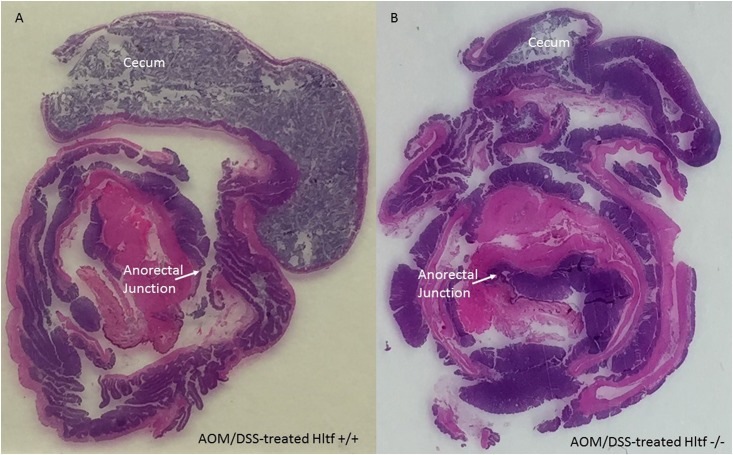
H&E stained Swiss-rolled colons.The entire large intestine for wild type control (A) and Hltf-deleted (B) mice is shown in each photomicrograph beginning with the cecum in the outmost region of the roll, continuing to the rugated region of the proximal colon, and terminating with the anorectal junction in the innermost region of the roll. Tumors and cellular inflammatory infiltrate in tumor stroma are evident in the distal colon. Pronounced loss of crypt architecture is evident in Hltf-deleted tissue.